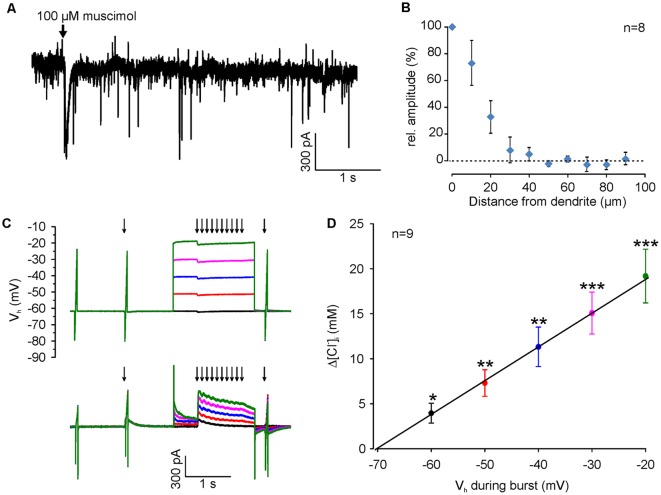
[Cl−]i increase upon burst-like GABAA receptor activation presents strong voltage-dependence. (A) Typical current trace of a neuron (recorded at −60 mV with a [Cl−]p of 50 mM) illustrating spontaneous synaptic currents and the inward current induced by focal application of 100 μM muscimol (arrow). Note that the evoked response had a slightly larger amplitude but last considerably longer than spontaneous currents. (B) Relative amplitude of muscimol-induced currents at various distances from the dendrite. Note the absence of evoked currents at distances >40 μm. (C) Original traces illustrating the stimulation paradigm. [Cl−]i was manipulated by a 10 Hz burst of single muscimol pulses (2 ms, 100 μM), while clamping the cell at different depolarized holding potentials from −60 to −20 mV. (D) The increase in [Cl−]i (Δ[Cl−]i) detected 500 ms after the end of the burst is strictly voltage-dependent. Data points represent mean ± SEM. Asterisks on top of values indicate significance from 0. *,**,***Indicate significance levels of p < 0.05, p < 0.01 and p < 0.001, respectively.